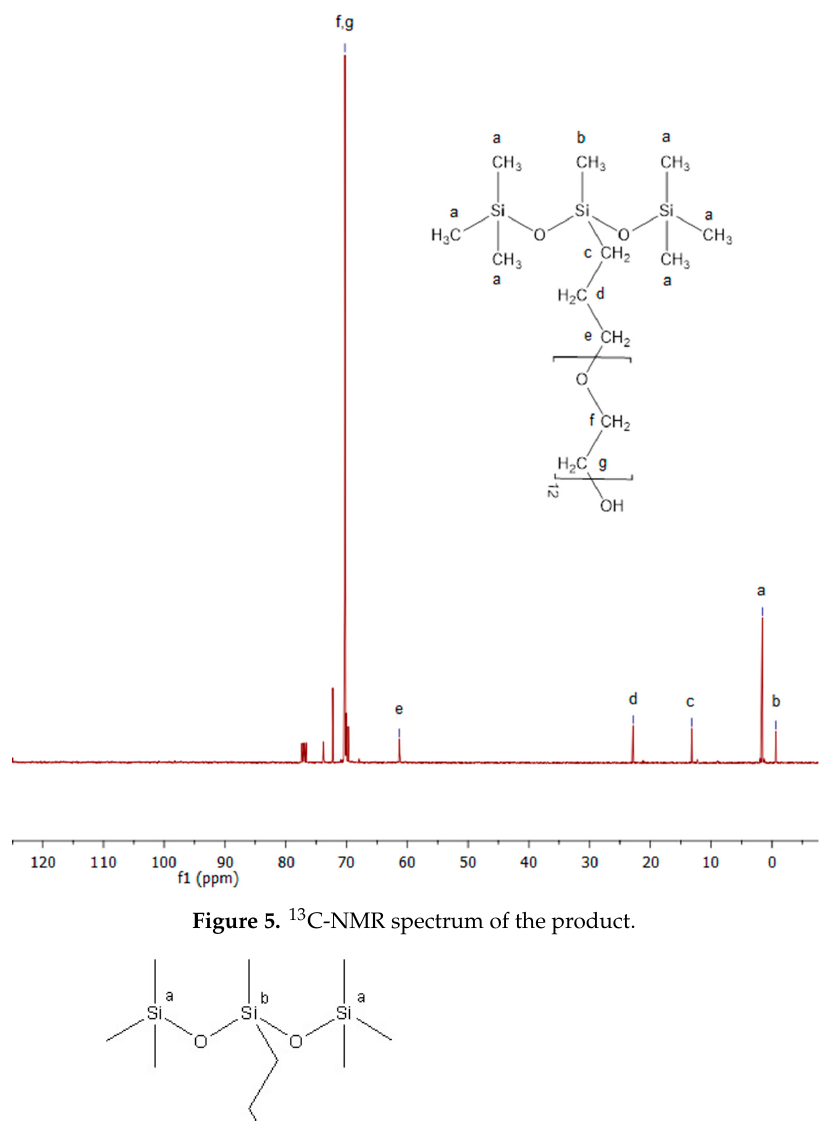
Figure 5. 13 C-NMR spectrum of the product.